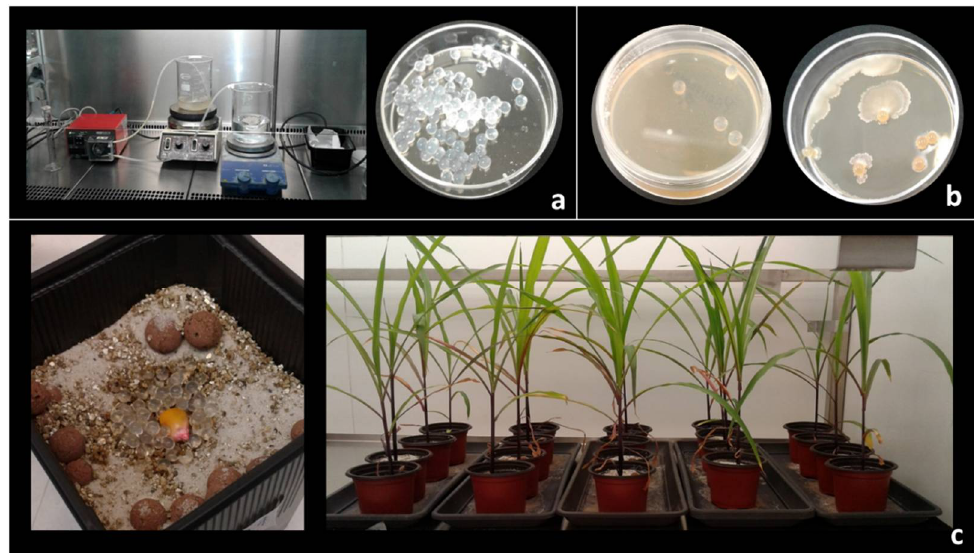
Figure 6. ( a ) Bacteria encapsulation in alginate beads. ( b ) Alginate beads cultivated in LB medium. Bacteria grows outside of spheres. ( c ) Maize seeds inoculated with B. subtilis encapsulated in alginate beads. Maize plants growing in the greenhouse.